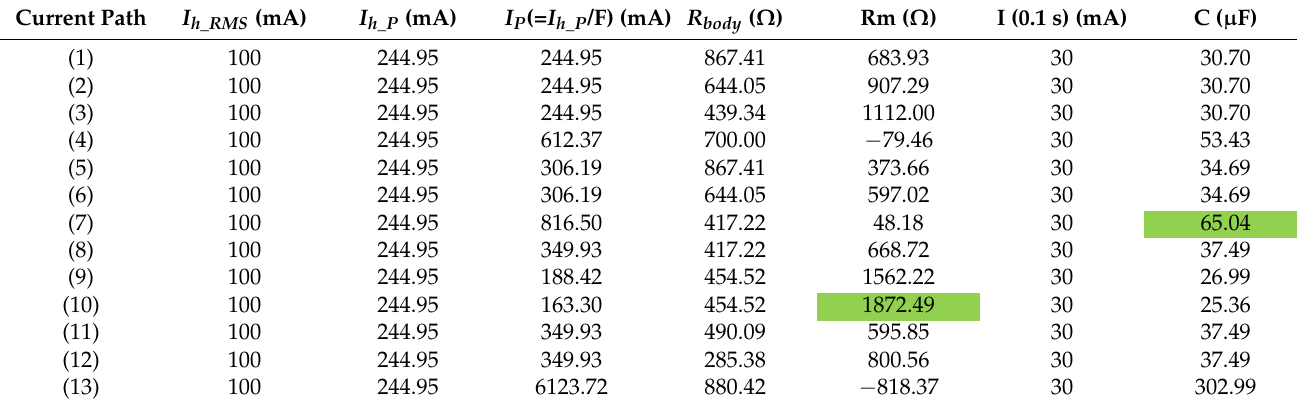
Table 7. Parameter calculation reflecting current flow path in human beings (700 Ω ) when the mid-point ground using the RC element is applied in a 380 V source